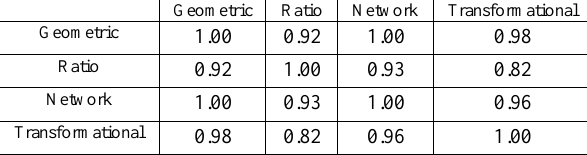
Figure 4 Representation of Running Examples in the Transformational Model The arrow-line indicates the direction of the transformation. It can be seen that the number of operations is not symmetric.